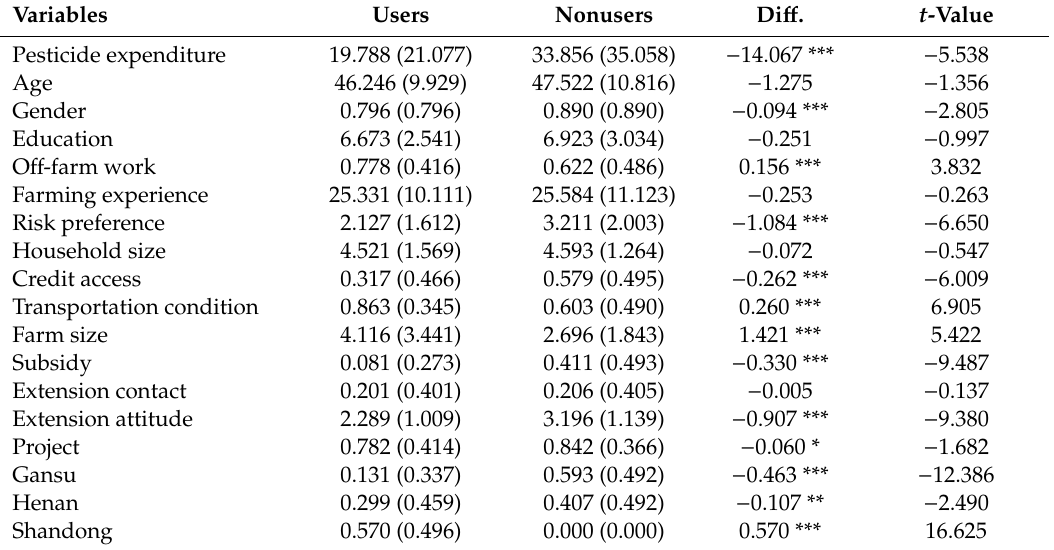
Table 2. The mean di ff erences in characteristics between farm machine users and